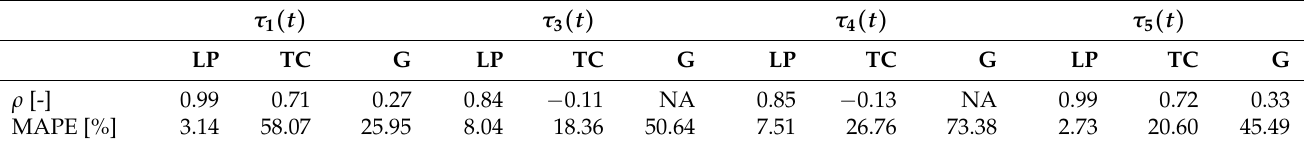
Table 2. Correlation coefficient ρ and MAPE of ALPR (abbreviation LP), thermal camera data (abbreviation TC), Google Distance Matrix API data (abbreviation G) and the 10 min MA ground truth flow data. Note that a correlation denoted as NA=not available means that the time